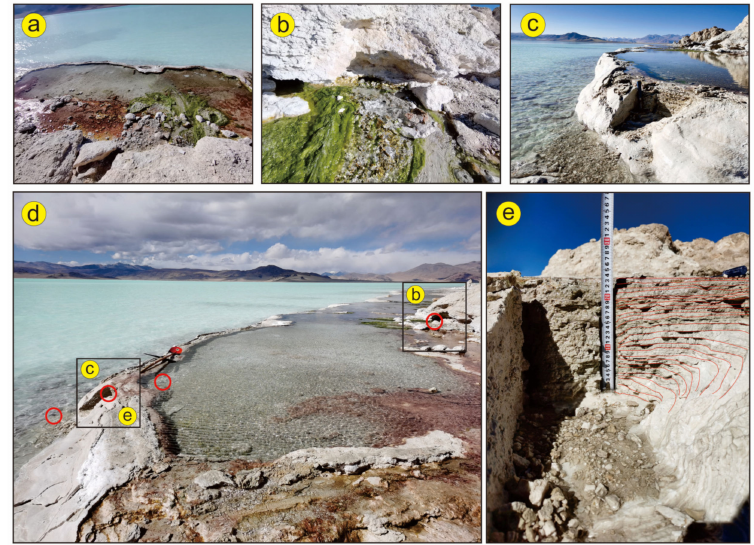
Figure 2. Outcrops of Zabuye Salt Lake. ( a ) Travertine dam formed by spring. ( b ) Spring outlet. ( c–e ) Close-up of travertine sampling sites, indicated by red circles. Black squares indicate the positions of ( b , c , e